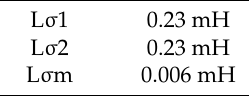
Table 1. Numerical results obtained for a designed FSCW structure having 12 slots and 10